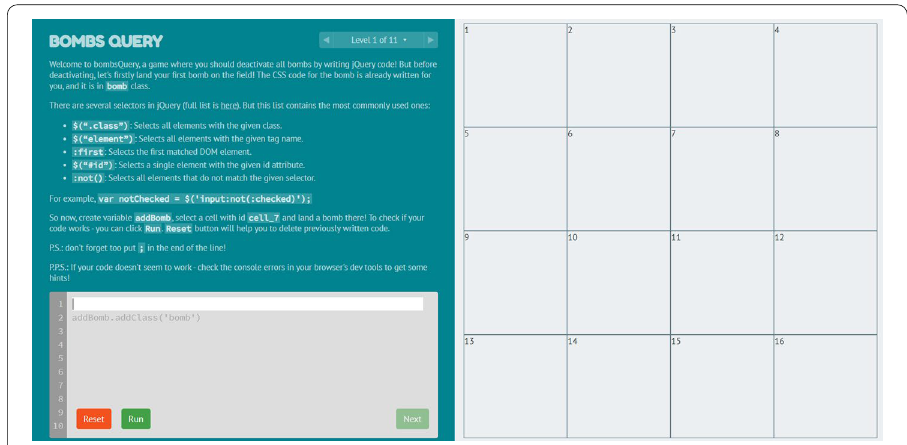
Fig. 1 An example of the gamified educational system bombsQuery, presenting a “welcome message” and